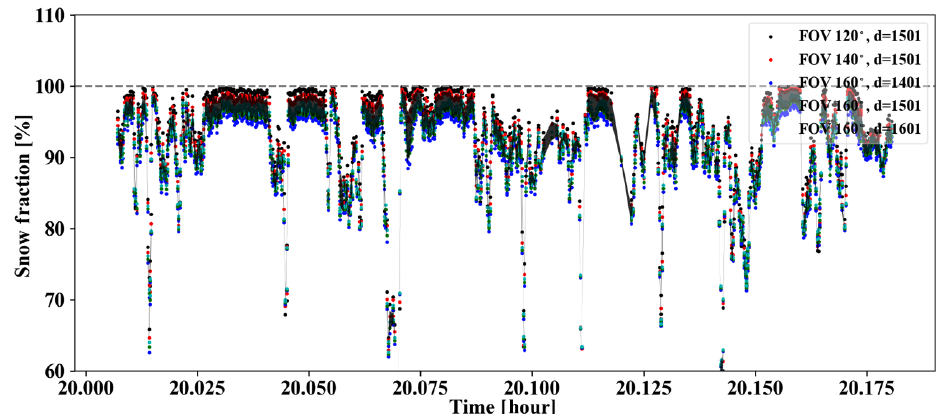
Figure D2. Snow fraction estimated using different FOV angles and subdomain sizes in the adaptive thresholding. The SD of the five sets of snow fraction is shaded in